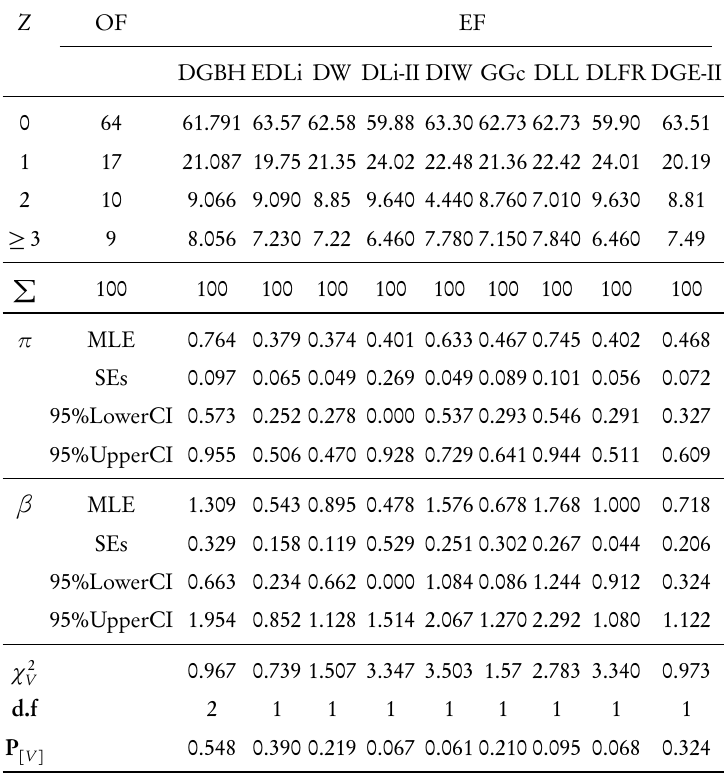
OF, EF, MLE, SEs, 95% CIs, χ 2